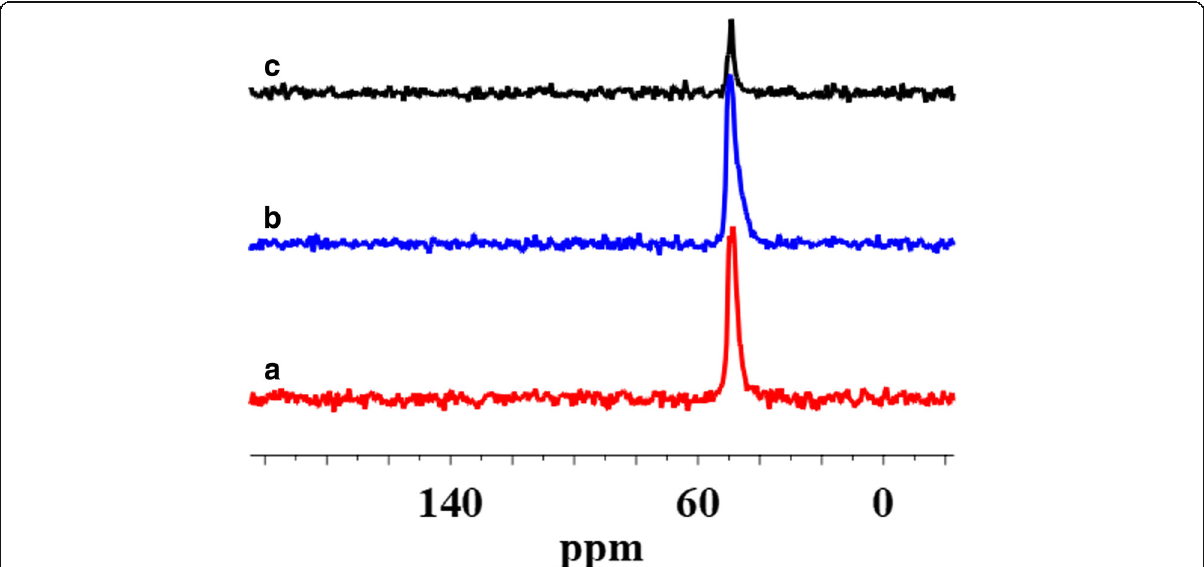
Fig. 9 13 C CP/MAS NMR spectra of ( a ) modified fumed silica with neat PDMS, modified with ( b ) mixtures of PDMS and dimethyl carbonate and ( c ) mixtures of PDMS and diethyl